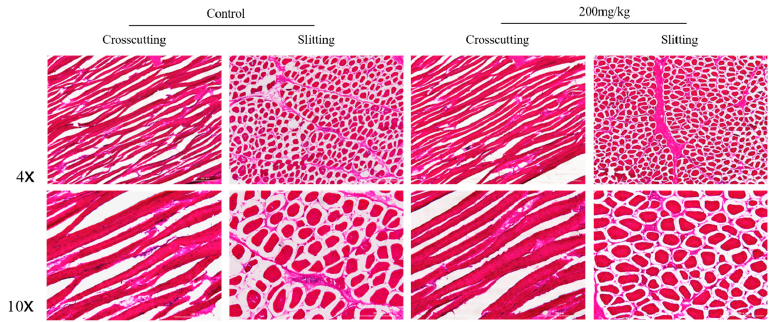
Figure 3. Light micrograph of HE staining showing the pectoral muscle in which there is a similarity in mean fiber cross-sectional area between the 200 mg/kg L -theanine and controls. Scale bar: 200 μ m.